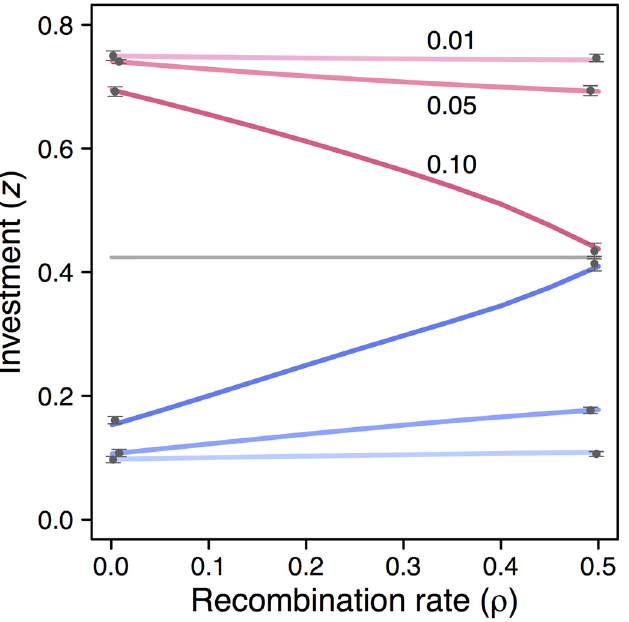
Fig 2. Evolutionary equilibrium dimorphisms. The equilibrium dimorphisms z 1 and z 2 , color coded blue and red, are plotted as functions of the rate of recombination ρ between cue and modifier loci. The two habitats differ in the size of social groups, with N 1 = 20 and N 2 = 2, resulting in lower relatedness in habitat 1 ( r 1 = 0.05) than in habitat 2 ( r 2 = 0.5). Three examples are shown, labeled with the rate of migration between habitats: m 12 = m 21 = m = 0.01, 0.05, 0.10. The total population size is the same in both habitats, and the parameters for the public goods game are also the same: W 1 = W 2 = 0.5, b 1 = b 2 = 3.0, c 1 = c 2 = 1.5. The gray horizontal line shows the equilibrium of gradual evolution in a monomorphic population, which does not depend on m or ρ . The dark gray points (with error bars) at ρ = 0.0 and ρ = 0.5, shifted slightly left and right for visibility, show mean and standard deviation of the average phenotype over 10 replicate individual-based evolutionary simulations. In these simulations, a g in Eq (5) was encoded by a single locus whereas a 0 was kept at a fixed value (see S1 Text for further